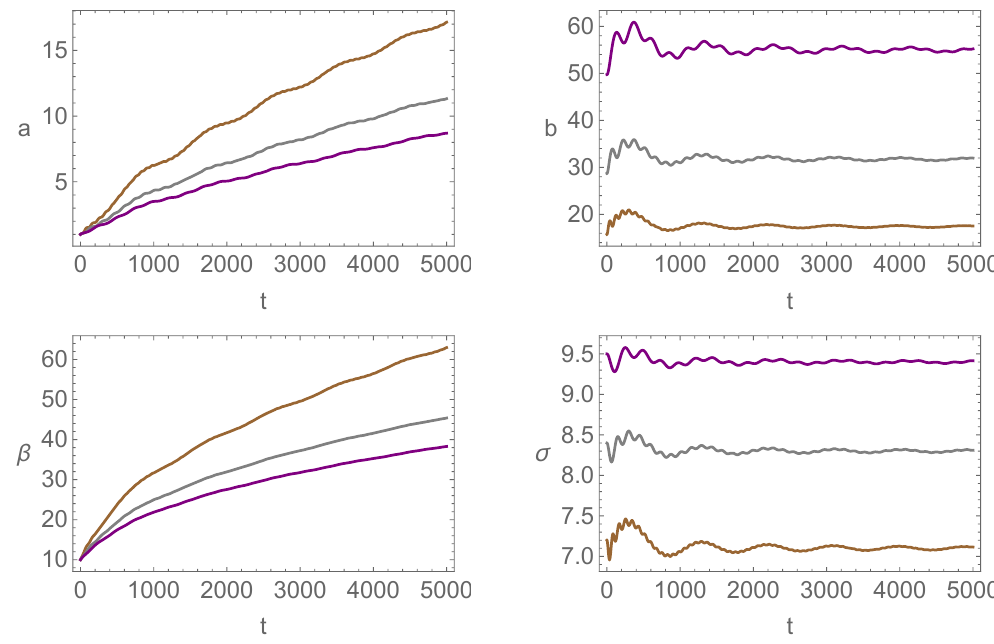
Figure 7. Time evolution of the scale factors { a, b } , the inverse temperature β , and the dilaton σ . The value of σ is chosen from the bottom to the top as σ ∗ = 0 . 03 , 0.1, 0.3, respectively. The other parameters are chosen as m 2 b 2 vac